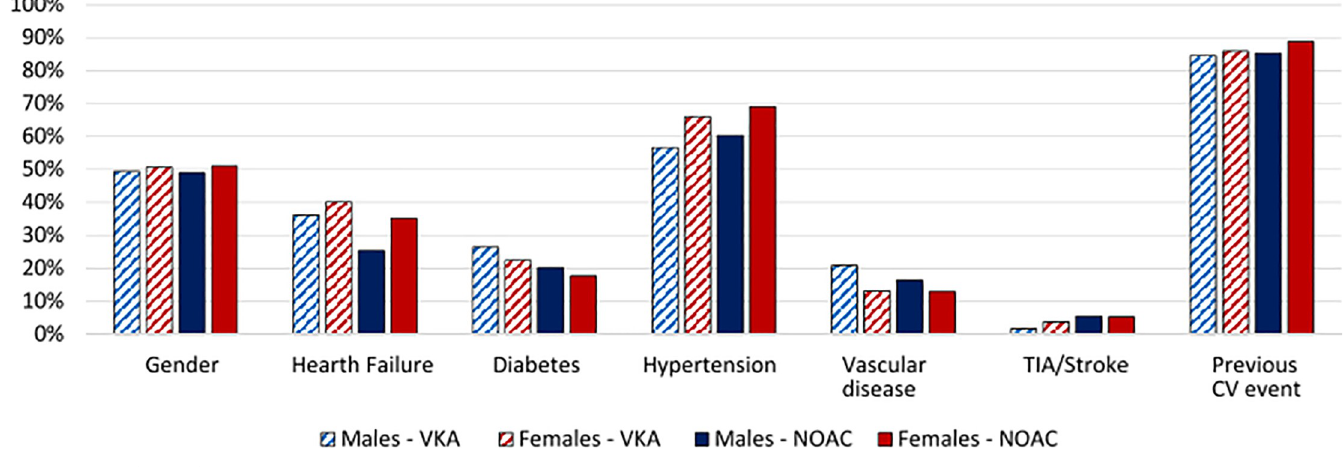
Fig 2. AF population characteristics.